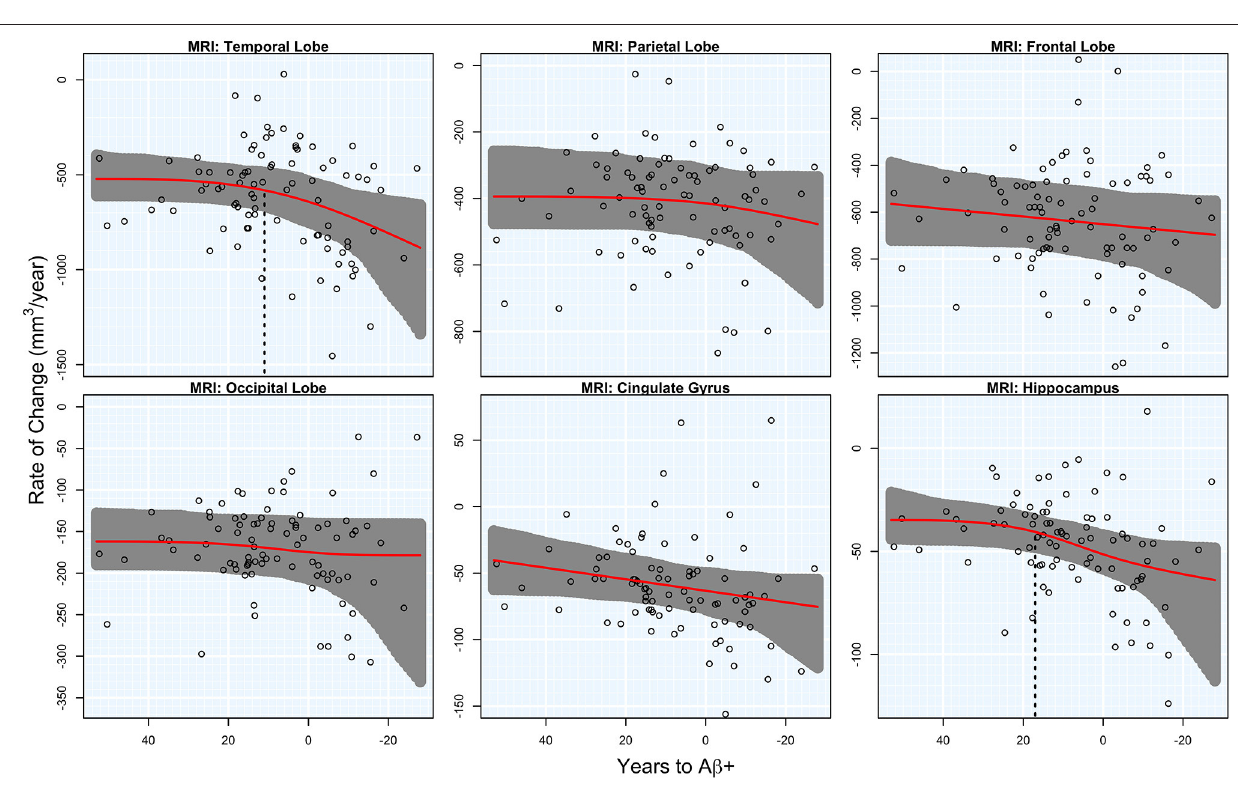
FIGURE 3 | MRI rates of change. Annual rates of change of MRI regions are plotted against T2A β + . Atrophy rates increase from top to bottom and time to A β -positivity decreases from left to right. Estimated curves are in red with 95% confidence intervals shaded in gray. The vertical dashed line in black is the estimate of the initial acceleration point, if it